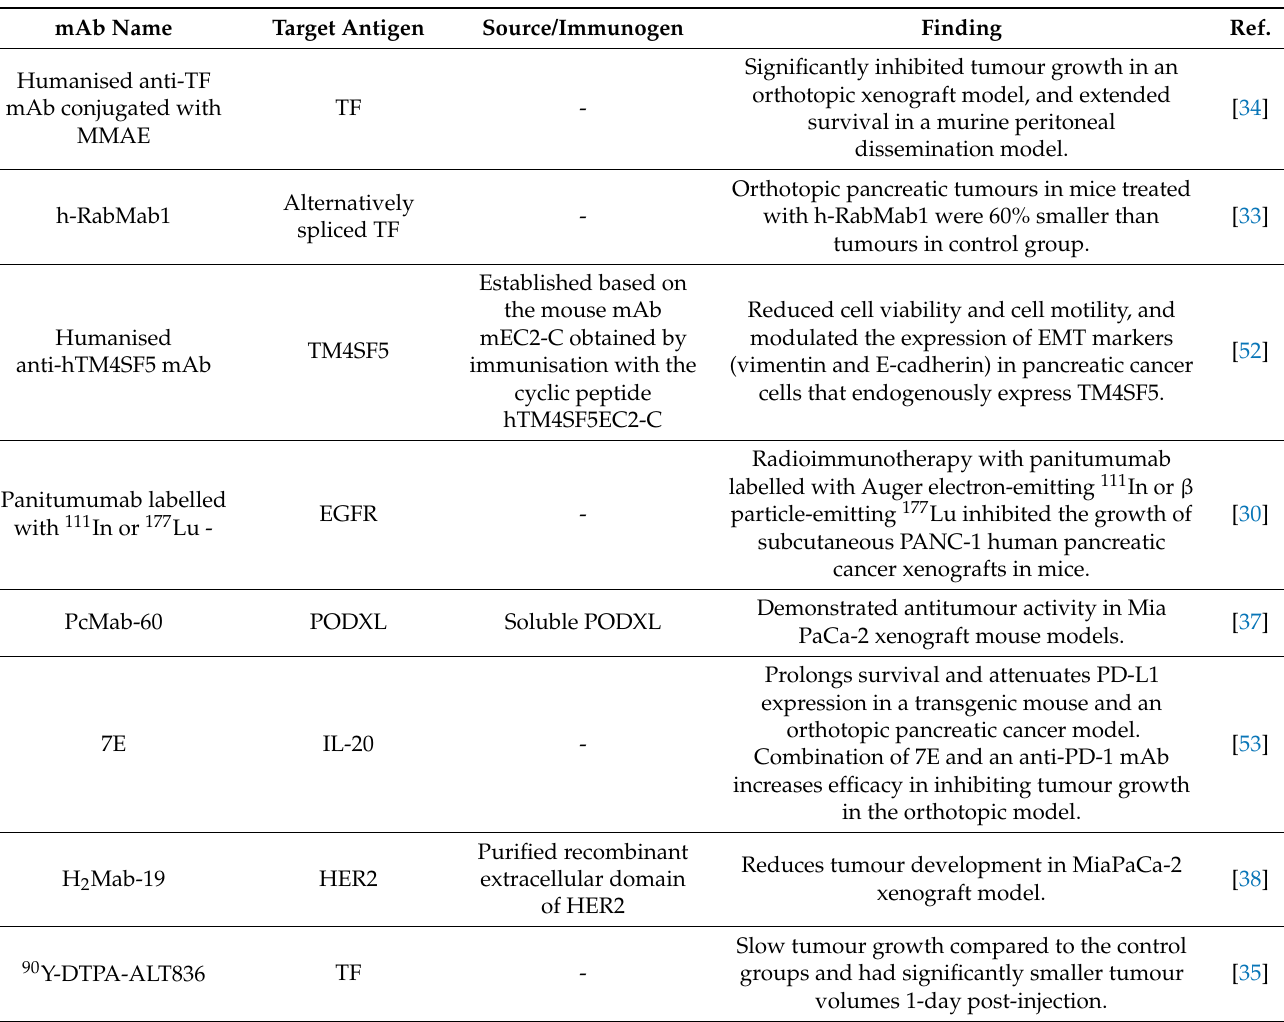
Table 2. Monoclonal antibodies against pancreatic cancer in preclinical studies for use as therapeutic